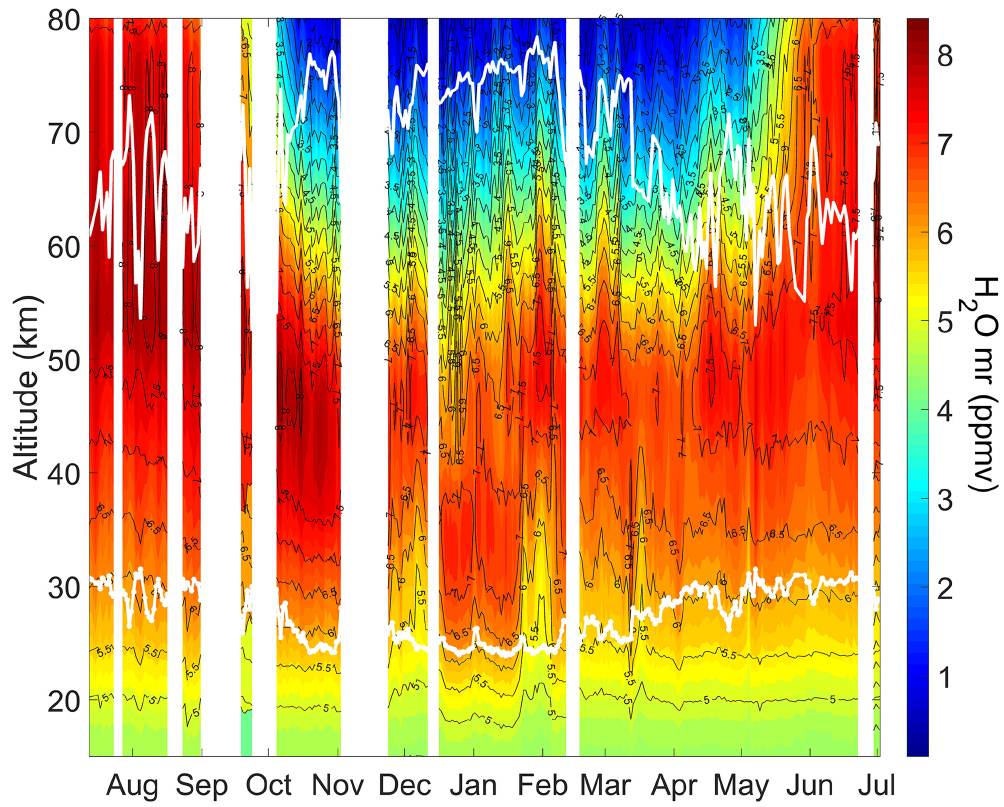
Figure 15. A map showing the VESPA-22 retrieved profiles (colored areas) compared to MLS convolved profiles (black lines). The blank areas indicate the lack of VESPA-22 data for more than 3 days. White solid lines indicate the time series of the sensitivity